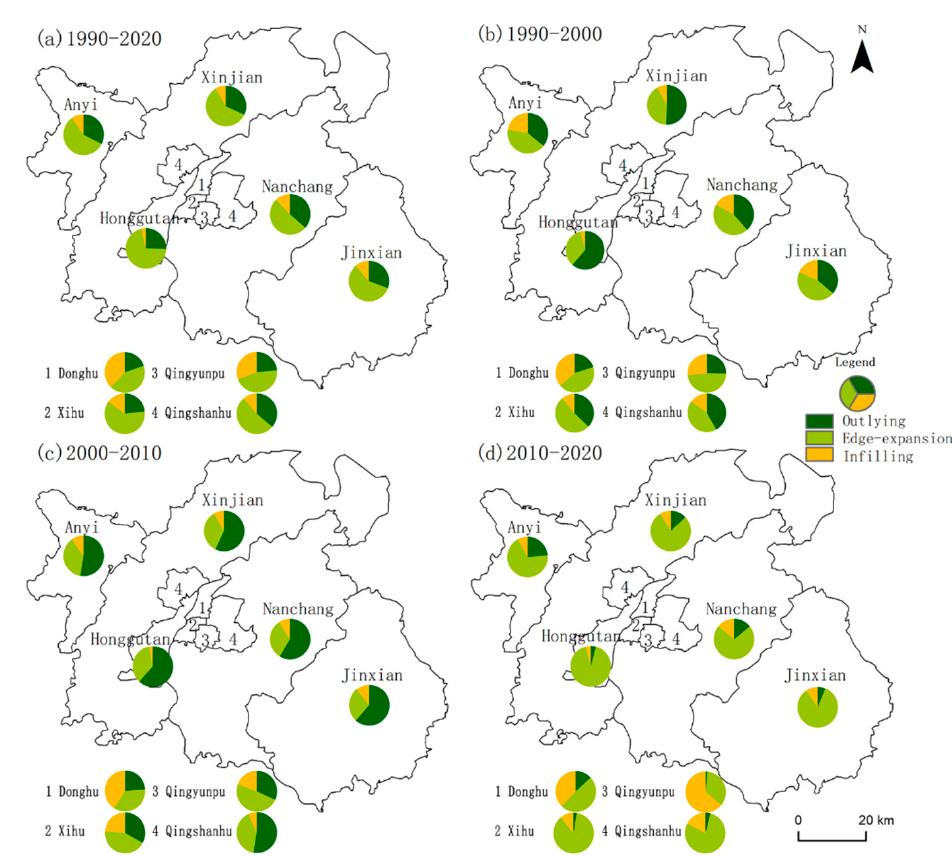
Figure 5. Spatial distribution characteristics of three types of spatial expansion from 1990 to 2020.